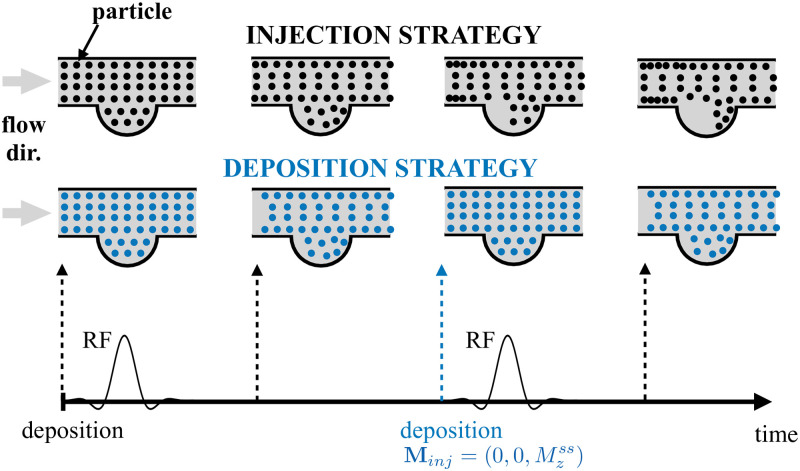
Schematic illustration of the particles position at different instants between two consecutive RF excitations in a pipe flow with an aneurysm-like wall bulging.The black spheres represent the classical particles injection strategy where particles are initially seeded within the whole domain and continuously injected from the inlet boundary surface. In contrast, in the proposed seeding strategy (blue spheres), the particles are periodically re-seeded at their initial location, and the steady-state magnetization is prescribed. In the classical strategy, zones of agglomerated and empty particles can be observed especially in the aneurysm sac [23], while the proposed approach allows to keep homogeneous the particle repartition.